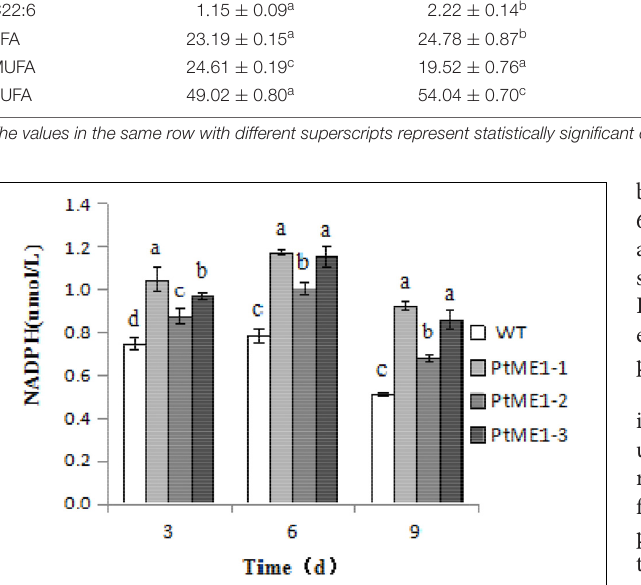
FIGURE 5 | NADPH content in the WT strain and the three Phaeodactylum tricornutum transformants. Values represent averages of three replicates ( n = 3). Values with different letters (a,b,c,d) indicate a significant difference between them ( p <